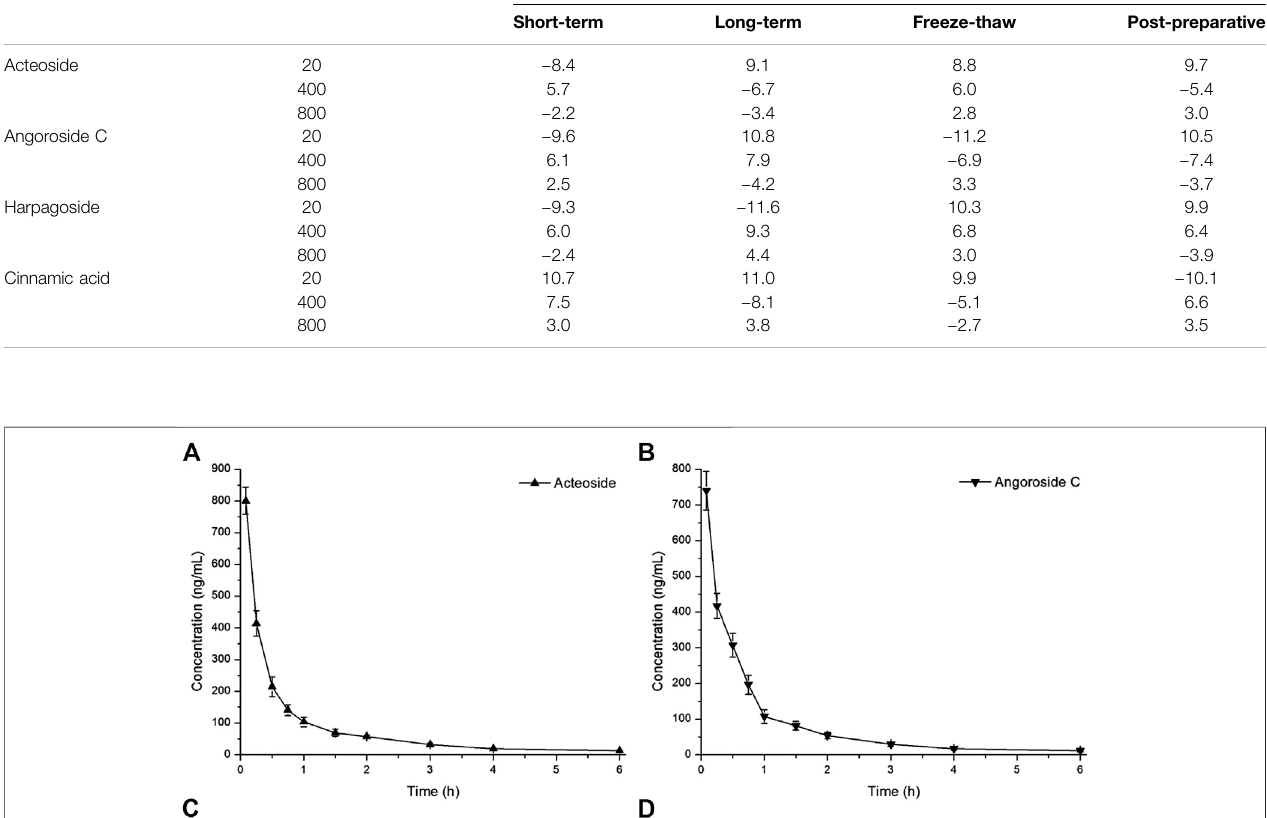
TABLE 2 | Summary of stability of QC samples under various storage conditions (n (cid:2) 5). Analytes